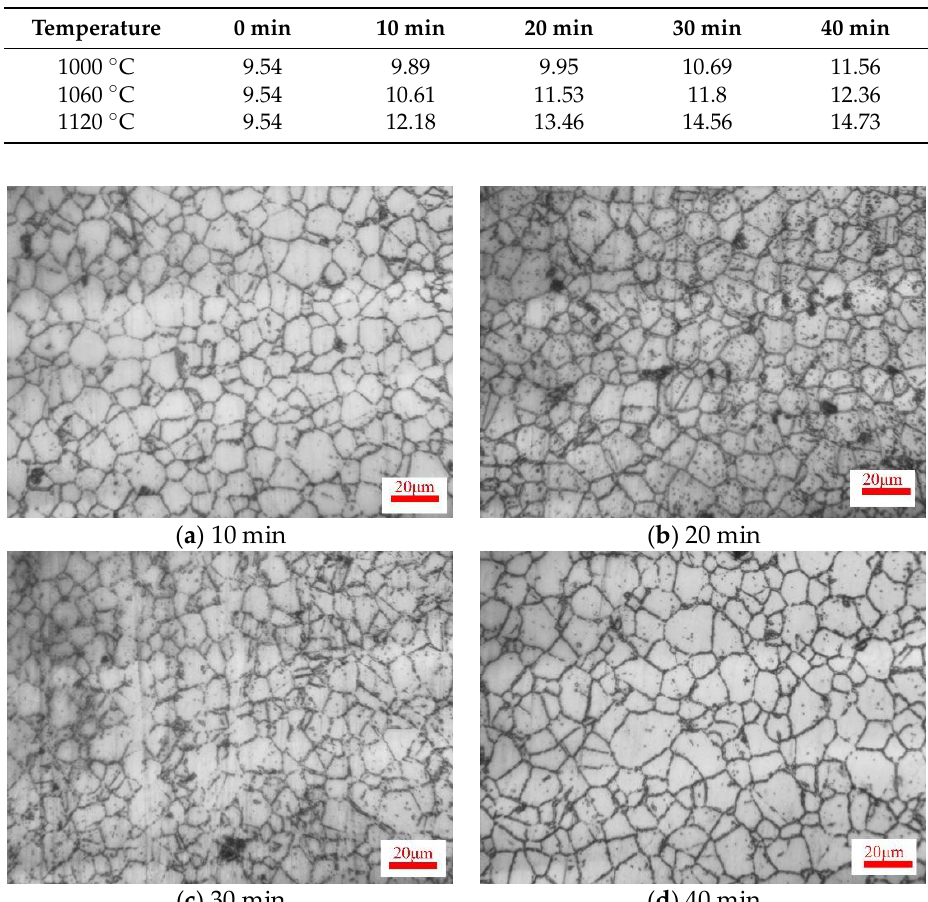
Table 3. Average grain size at different holding times and temperatures (Unit: μm).